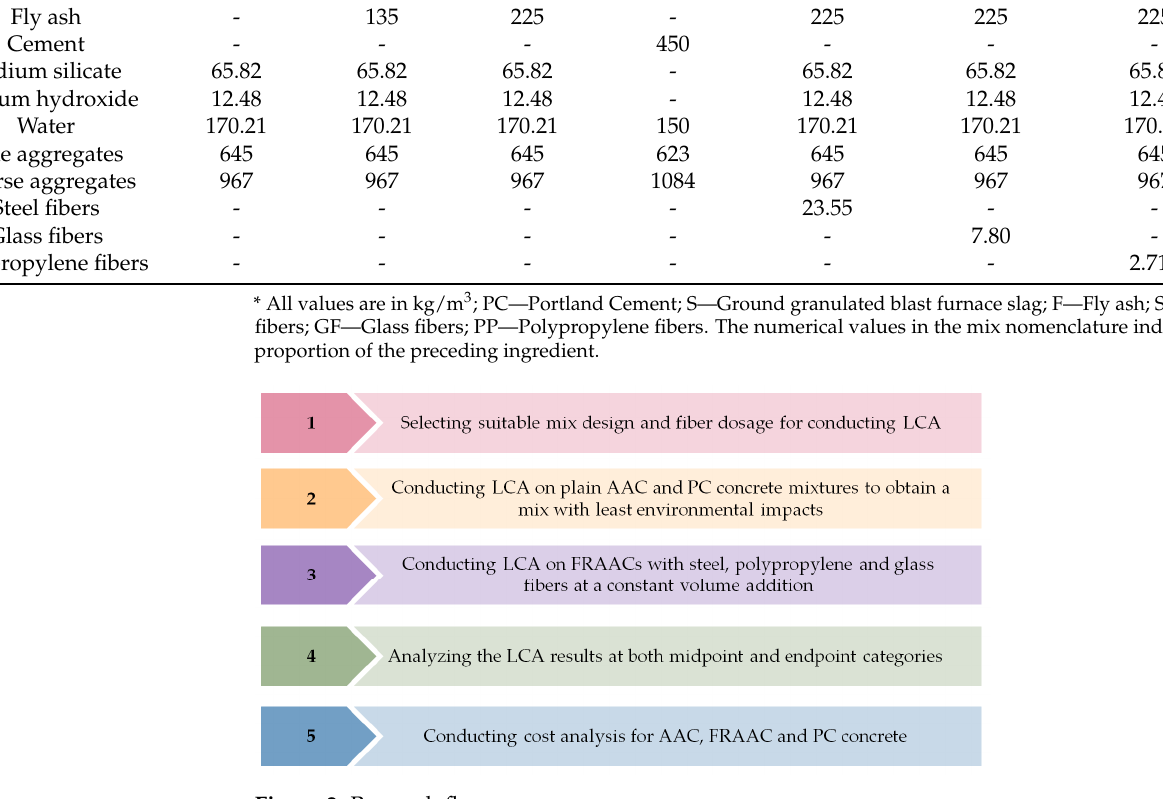
Figure 2. Research flow.